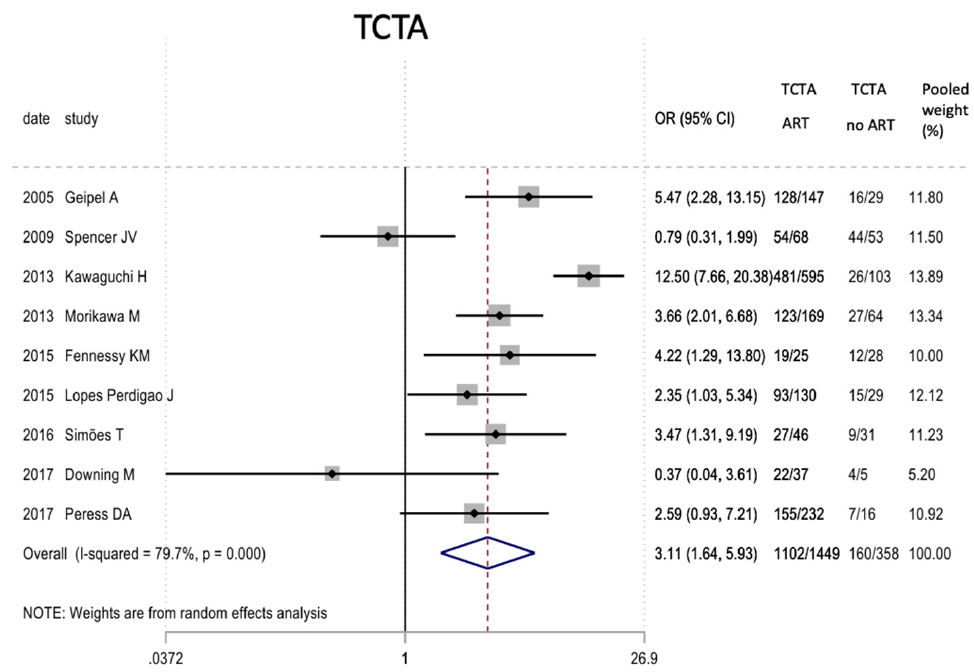
Figure 2. Results of the meta-analysis on the effect of assisted reproductive therapies on the chorionicity of pregnancies (TCTA vs. non-TCTA). TCTA: trichorial-triamniotic, non-TCTA: non-trichorial-triamniotic. OR = odds ratio, CI = confidence interval.